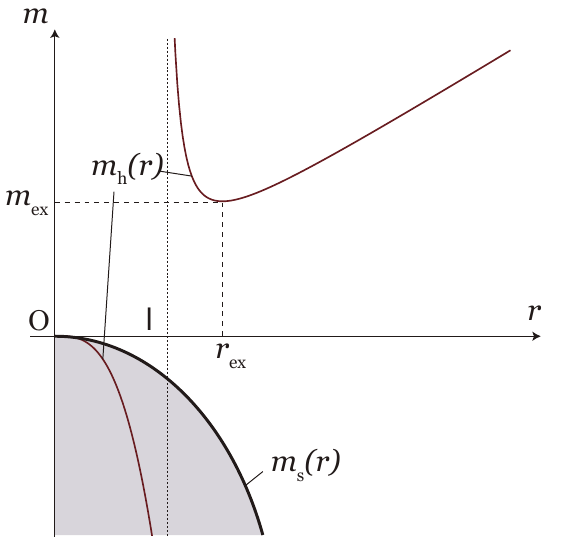
Figure 4 . The forms of m = m h ( r ) (thin curves) and m = m s ( r ) (a thick curve) given by eq. (3.27) and (3.29),